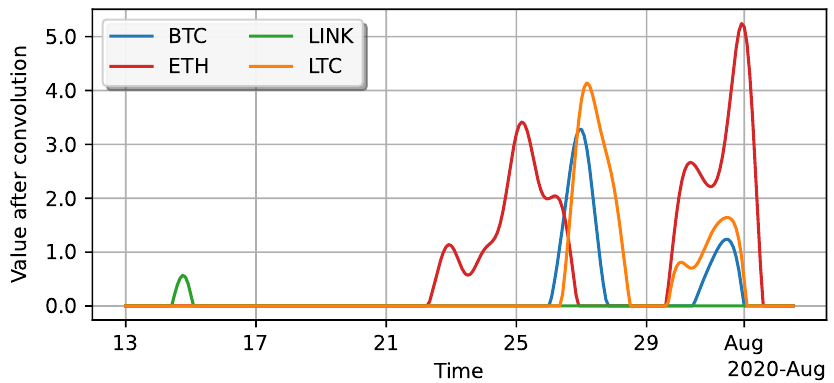
Figure 8. Values extracted by a convolutional